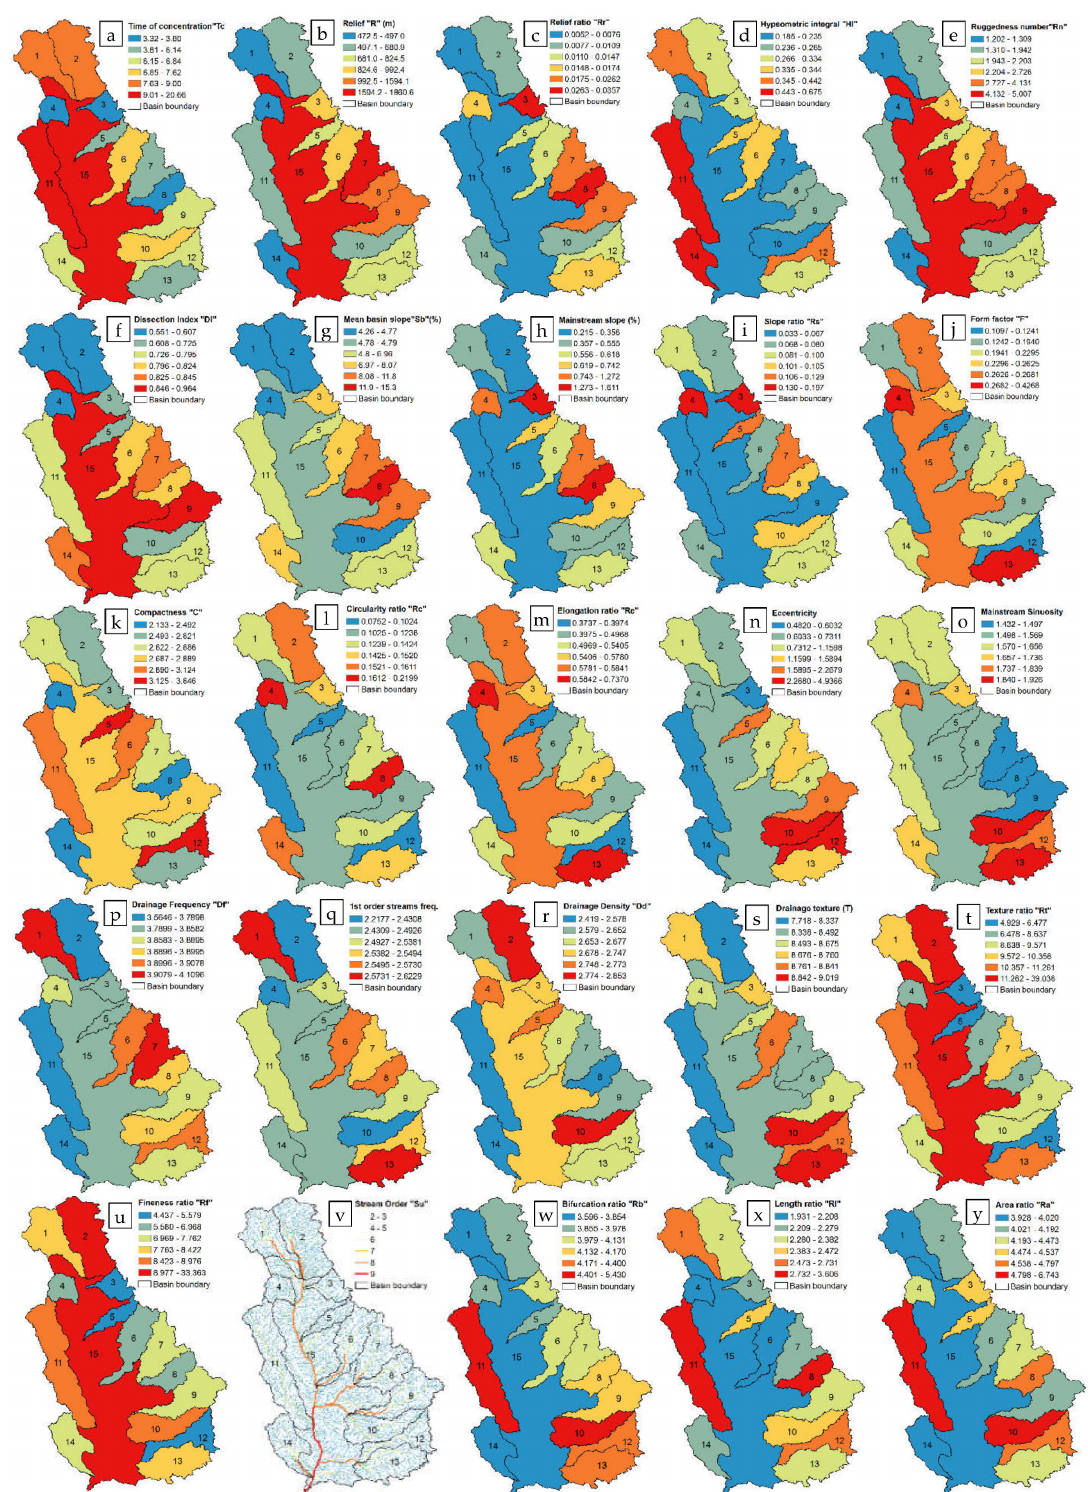
Figure 4. Wadi Qena geomorphometric analysis. The inner basin (15) records the average parameter values of the entire Wadi Qena